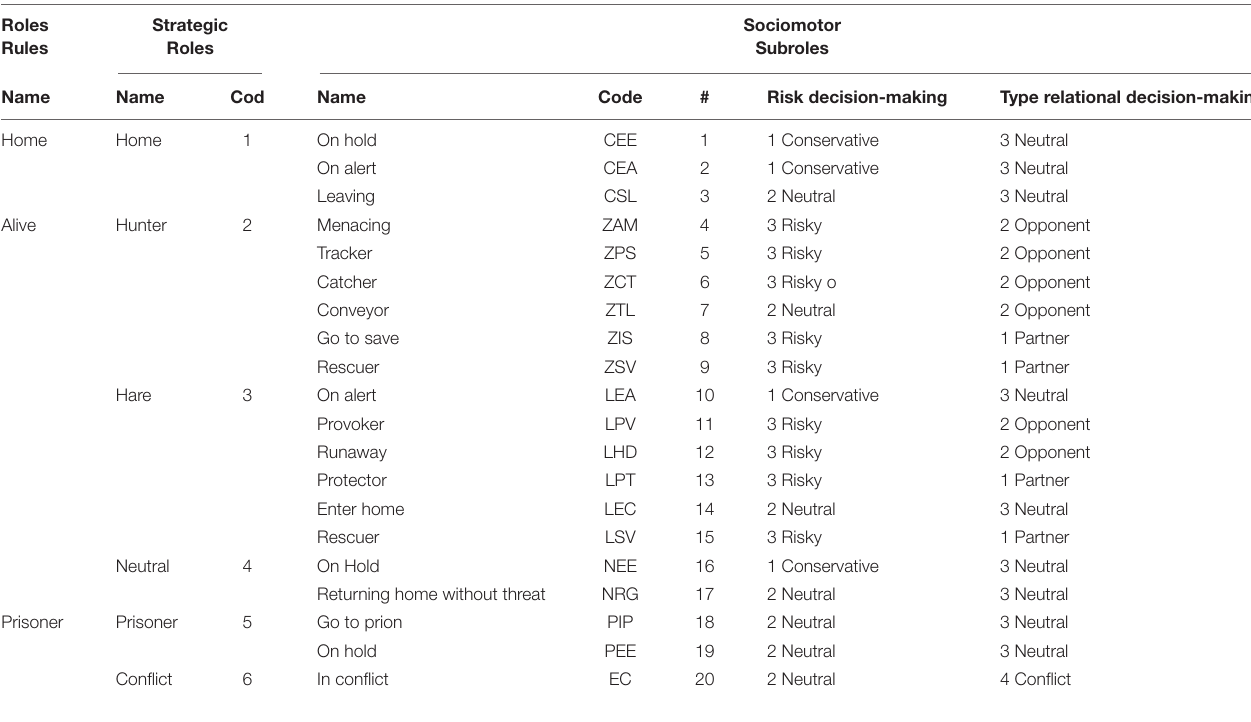
TABLE 1 | Relation of roles, subroles, and their level of risk and decisional relationships. Roles Strategic